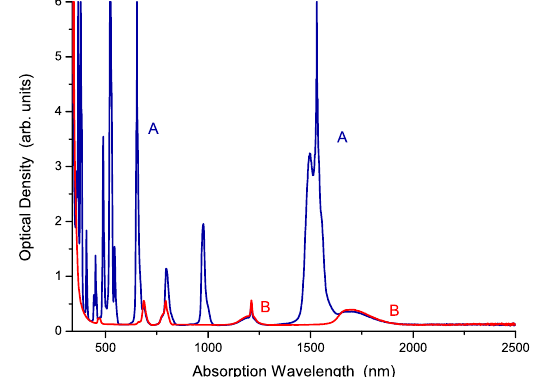
Figure 1. Absorption spectra of samples (A) Er 3 + (8%)Tm 3 + (0.5%):telluride glass and (B) Tm 3 + (0.5%):telluride